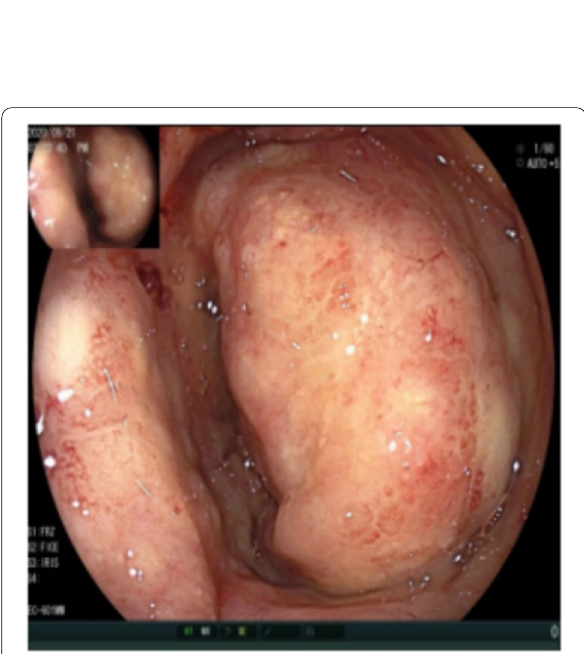
Fig. 4 Colonoscopy showing a neoplasm in the intestinal lumen of the